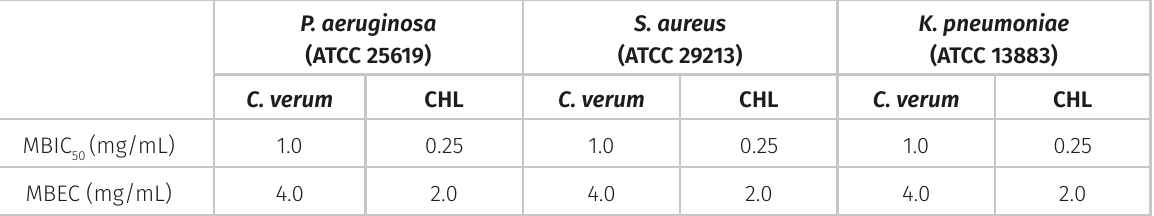
Table II. Minimum Biofilm Inhibitory Concentrations (MBIC (MBEC) for 24h established biofilms of P. aeruginosa (ATCC 25619), S. aureus (ATCC 29213) and K. pneumoniae (ATCC 13883). CHL: Positive control Chlorhexidine